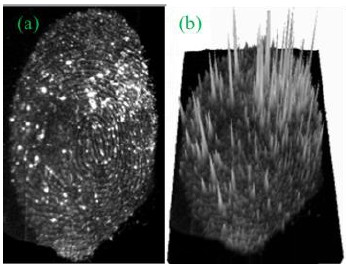
Figure 8. Fingermarks developed on transparent tape by G-CDs. ( a ) flat effect; ( b ) three-dimensional effect.